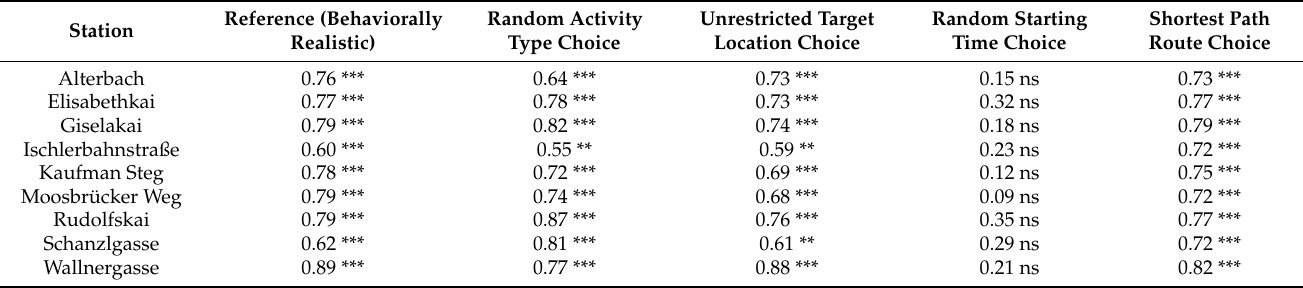
Table 6. Pearson’s correlation coefficients between the observed and simulated hourly totals of traversed cyclists at stations by scenario.